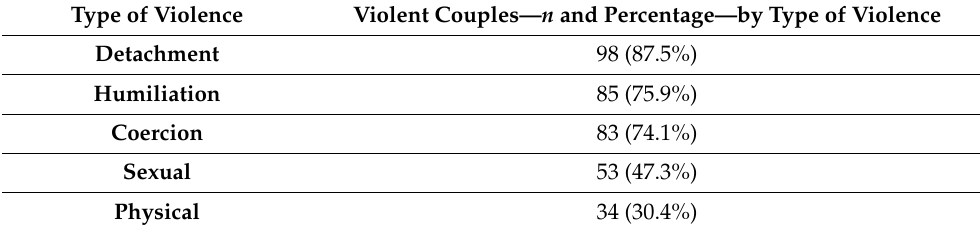
Table 2. Prevalence of the types of violence (DVQ-R) in violent couples. Type of Violence Violent Couples— n and Percentage—by Type of Violence